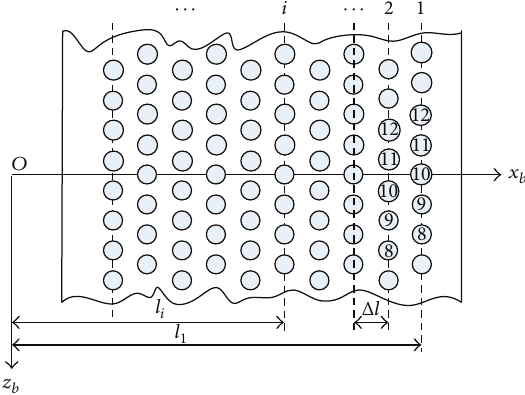
Figure 2: The layout scheme of lateral pulse jets.